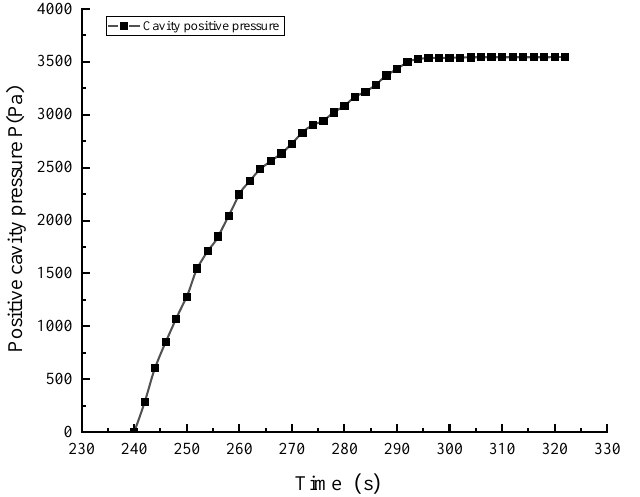
Figure 6. Time-lapse curve of the water supply and positive pressure of the dissolution chamber.